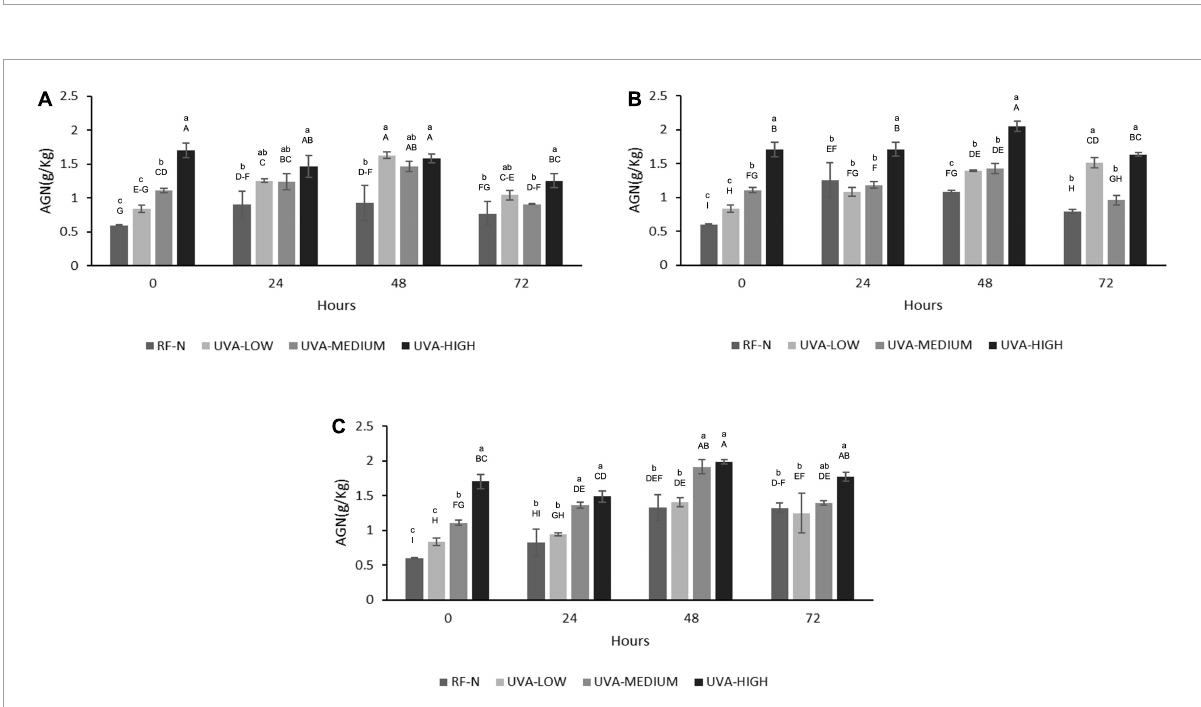
FIGURE5 Agrimoniin concentration (AGN) of UVA-treated strawberry by-products during storage at (A) 5 ◦ C, (B) 10 ◦ C, (C) 15 ◦ C. RF-N: Strawberry agro-industrial by-product control. UVA-LOW: RF irradiated with 28.8 KJ/m 2 . UVA-MEDIUM: RF irradiated with 57.6 KJ/m 2 . UVA-HIGH: RF irradiated with 86.4 KJ/m 2 . Different lower-case letters mean significant ( p ≤ 0.05) differences among treatments at the same storage time. Different capital letters mean significant differences ( p ≤ 0.05) among different storage